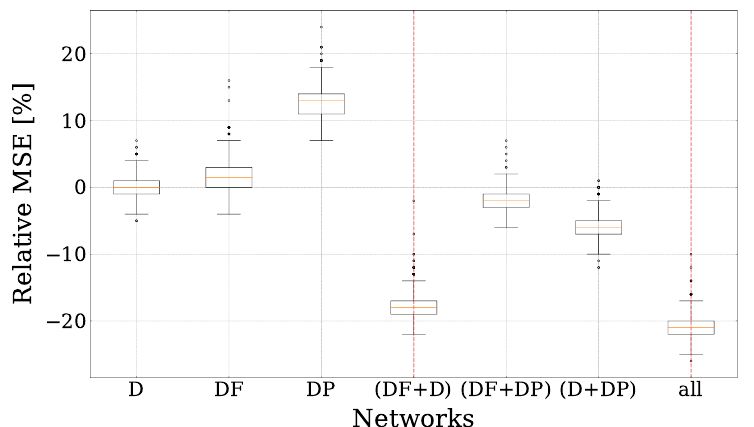
Figure 7. Boxplots represent the training MSE results of the algorithms using UX, N = 20, 24, 30 samples with complexity (3, 2). The x-axis represents the algorithm inputs we applied, and the y-axis denotes the relative MSE calculated, with D -input algorithms as a reference case.